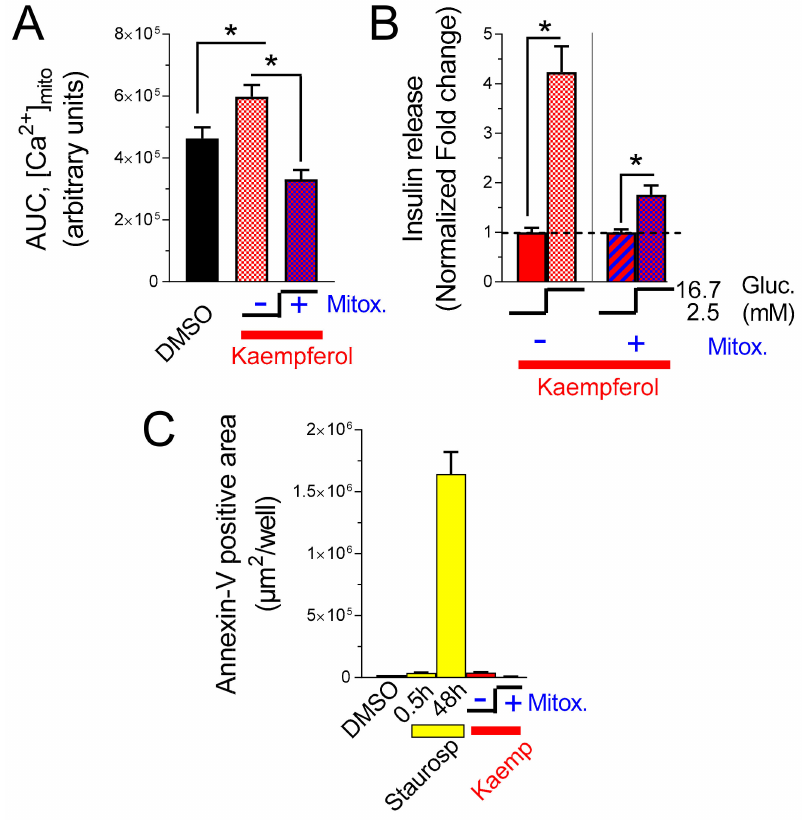
Figure 5. Kaempferol-induced mitochondrial Ca 2 + rise and insulin secretion are prevented in mitoxantrone-treated cells. ( A ) Mitochondrial-targeted mutated aequorin was reconstituted with native coelenterazine in INS-1E cells. Then, the cells were treated for 30 min with 1% DMSO or 10 µ M kaempferol in absence ( − ) or presence ( + ) of 50 µ M mitoxantrone. Finally, the cells were placed in the plate reader and stimulated with 16.7 mM glucose. The bars represent the statistical evaluation of the integrated mitochondrial Ca 2 + elevation evoked by glucose stimulation. Data are the mean ± SEM of 10 independent experiments (one-way ANOVA test. *, p < 0.05). ( B ) Insulin release was quantified as described in Figure 3B in INS-1E cells treated for 30 min with 1% DMSO or 10 µ M kaempferol in absence ( − ) or presence ( + ) of 50 µ M mitoxantrone. Shown is the average of 6 experiments (mean ± SEM; Student’s t -test). ( C ) Apoptosis measured, as described in Figure 4, at 30 min, in INS-1E cells treated with 1% DMSO (black), or 10 µ M kaempferol in absence ( − ) or presence ( + ) of 50 µ M mitoxantrone. Staurosporine 100 nM is shown as a positive control of cell death (yellow) and it is quantified at 0.5 h and 48 h, as indicated. Representative results are shown (mean ± SEM of 3 replicates. *, p < 0.05). The experiment was repeated 3 times with comparable